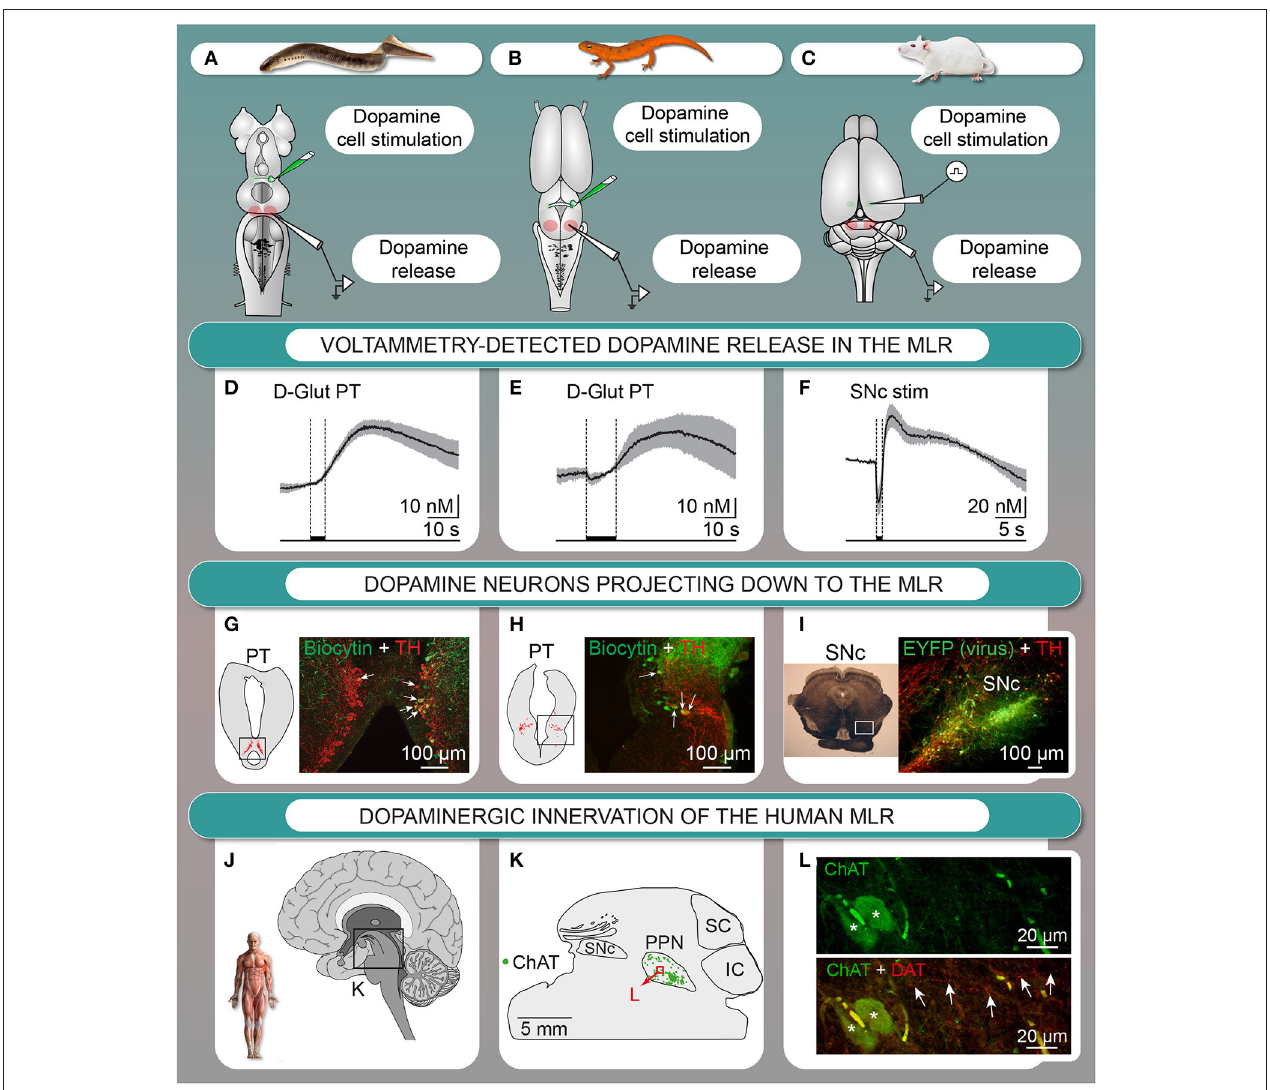
FIGURE 2 | The descending dopaminergic (DA) pathway is conserved from basal vertebrates to mammals. (A–F) Dopamine is released in the MLR after chemical stimulation of DA cells in the posterior tuberculum (PT) of lampreys (A,D) or salamanders ( in vitro isolated brain) (B,E) , or after electrical stimulation of the substantia nigra pars compacta (SNc) in rats (anesthetized) (C,F) . (D–F) mean ± sem is illustrated. (G) Lamprey tyrosine hydroxylase (TH)-containing cells (red) in the PT and cells projecting to the MLR (green) with arrows indicating double labeled cells. (H) Salamander TH-containing cells (red) in the PT and cells projecting to the MLR (green) with arrows indicating double labeled cells. (I) DA cells in the SNc retrogradely labeled by an injection of a Cre-dependent adeno-associated virus encoding for the enhanced yellow fluorescent protein (EYFP, green) in the MLR of transgenic rats expressing the Cre-recombinase in TH neurons as shown by immunostaining against TH (red). (J–L) DA innervation of the human MLR. (J–L) The location of cholinergic cells (choline acetyltransferase-positive, ChAT) of the pedunculopontine nucleus (PPN), part of the MLR, is indicated. (L) Fibers containing the dopamine active transporter (DAT, red, highlighted by arrows) in proximity with cholinergic cells (ChAT, green) in the PPN. IC, inferior colliculus; SC, superior colliculus. (Panels A,D,G adapted from D. Ryczko, S. Gratsch, F. Auclair, C. Dube, S. Bergeron, M.H. Alpert, J.J. Cone, M.F. Roitman, S. Alford, and R. Dubuc, Forebrain dopamine neurons project down to a brainstem region controlling locomotion. Proceedings of the National Academy of Sciences of the United States of America 110 (2013) E3235–E3242. No permission is required for this reproduction; panels B,C,E,F,H,I,J–L adapted from D. Ryczko, J.J. Cone, M.H. Alpert, L. Goetz, F. Auclair, C. Dube, M. Parent, M.F. Roitman, S. Alford, and R. Dubuc, A descending dopamine pathway conserved from basal vertebrates to mammals. Proceedings of the National Academy of Sciences of the United States of America 113 (2016) E2440–E2449. No permission is required for this reproduction).